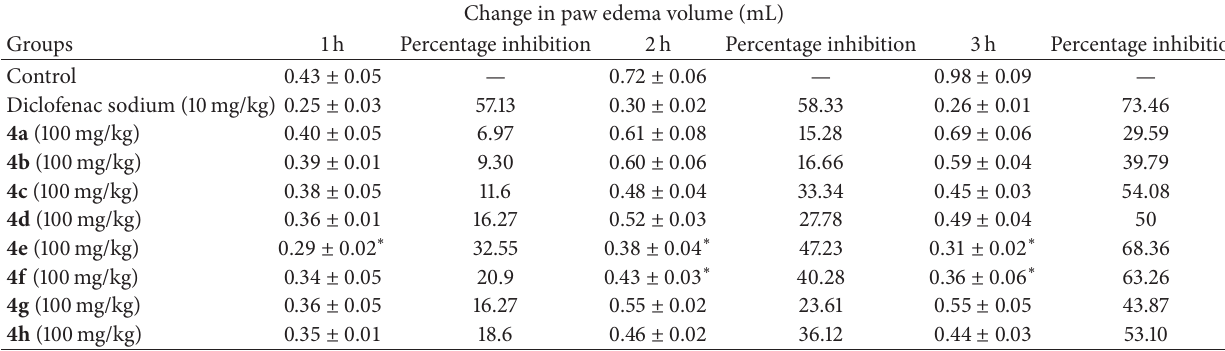
Table 1: In vivo anti-inflammatory activity of synthesized 1,3,4-oxadiazole analogues.